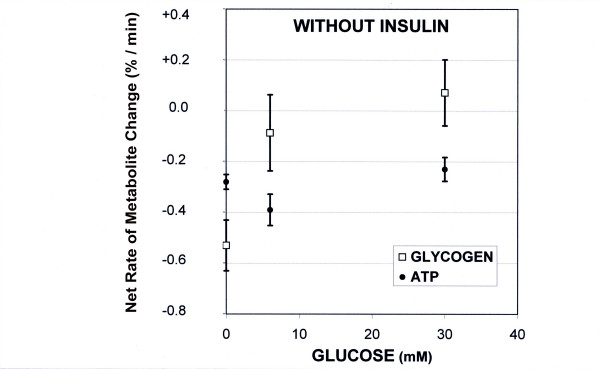
Rates of liver glycogen and ATP changes in absence of insulin in the perfusate. The results are expressed in %·min-1 (mean ± SEM; 100% initial glycogen content = 73 ± 8.5 μmol glycosyl units·g-1 liver wet weight; 100% initial ATP content = 2.60 ± 0.65 μmol/g liver wet weight). Only the rate of glycogen content increased with the perfusate glucose concentration.